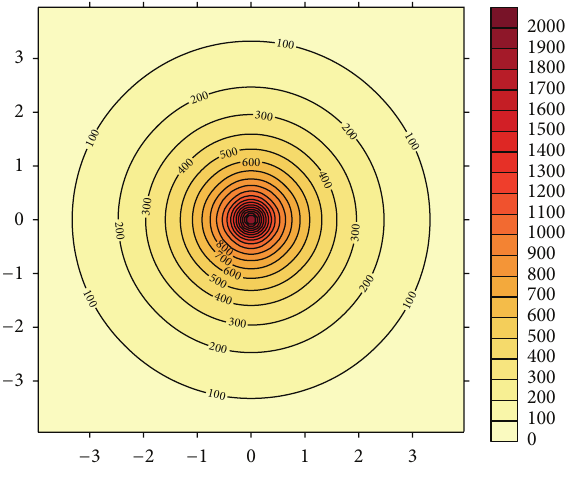
Figure 18: 300 ∘ C thermal expansion contours.